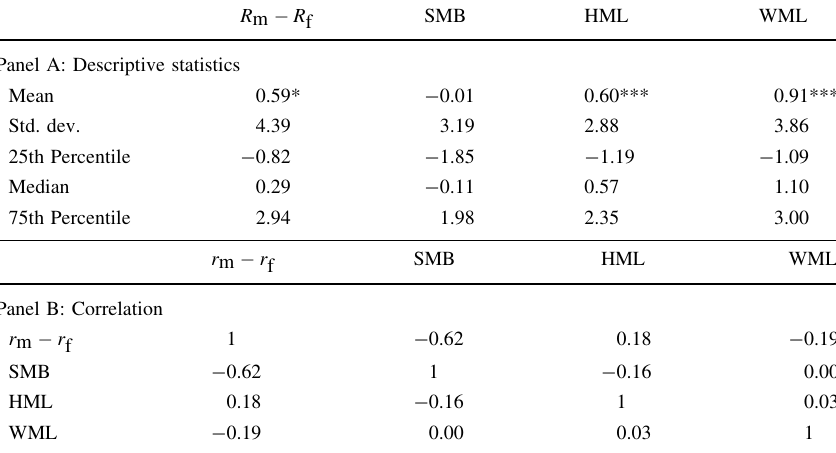
Table 4 Monthly averages, standard deviations and pair-wise correlations of the factor mimicking